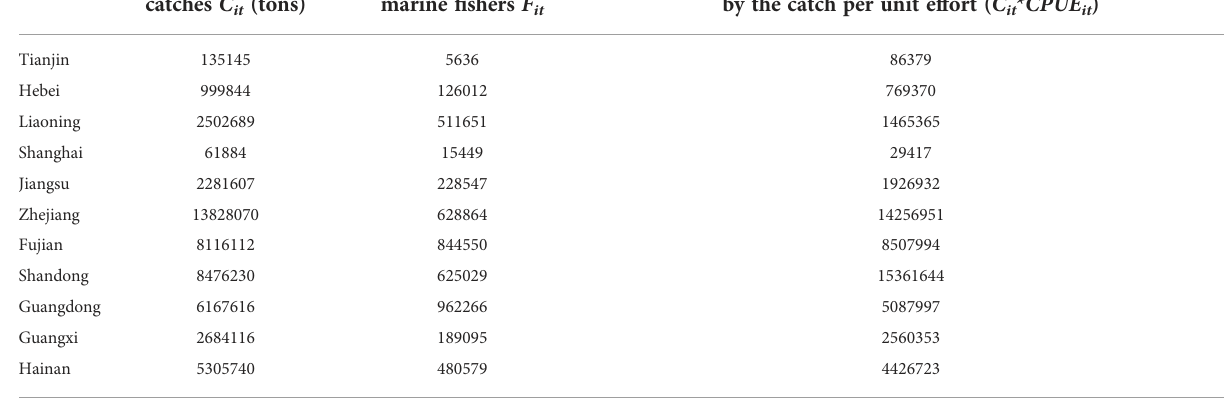
TABLE A.1 The cumulative value of selected indictors for 11 fi shing provinces in China during 2017 – 2021.